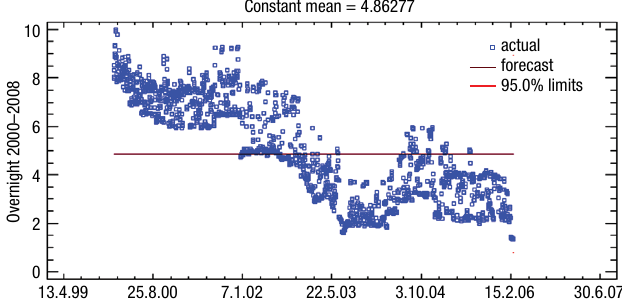
Constant mean = 4 86277.